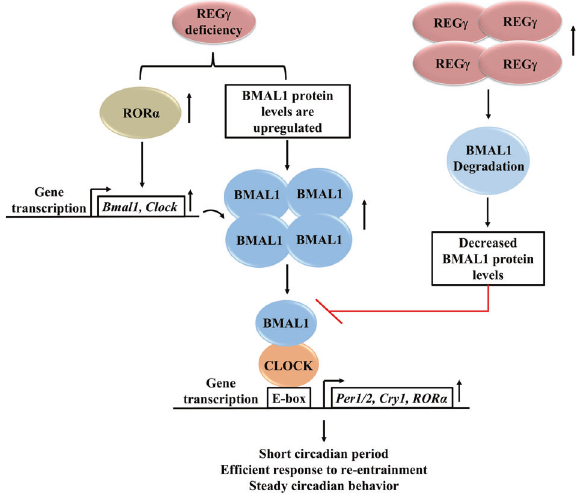
Fig. 6 A Model of REG γ -dependent regulation of circadian rhythms. In mammalian cells, REG γ promotes rapid degradation of circadian transcription factor BMAL1 to attenuate the expression of circadian core genes, thus in mice, the downregulated circadian clock causes defect in circadian entrainment and disturbed circadian rhythms. However, mice having de fi ciency of REG γ display short circadian period, ef fi cient response to re-entrainment, and steady circadian behavior. Cell Death Discovery (2021)